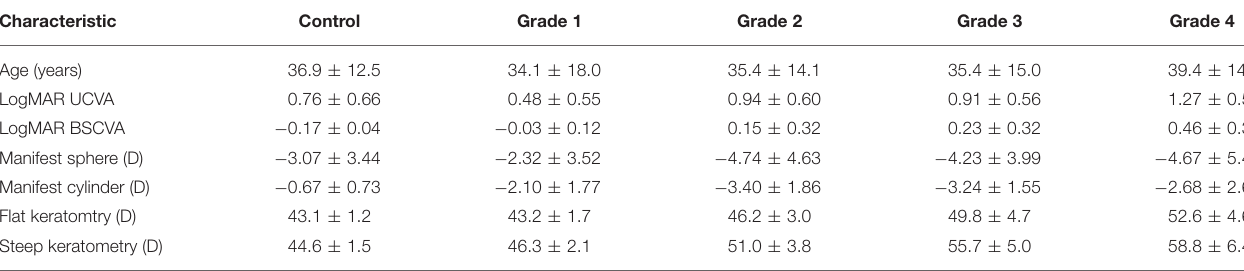
TABLE 1 | The demographics of the study population according to the Amsler-Krumeich classification. Characteristic Control Grade 1 Grade 2